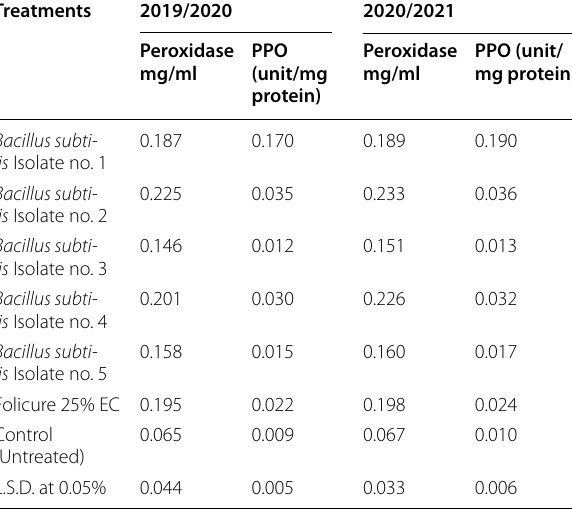
Table 6 Effect of Bacillus subtilis isolates and Folicure treatments on peroxidase and polyphenol oxidase activity of onion plants after 30 days from transplanting under field conditions at Mallawi, Menia governorate, during 2019/20 and 2020/21 growing